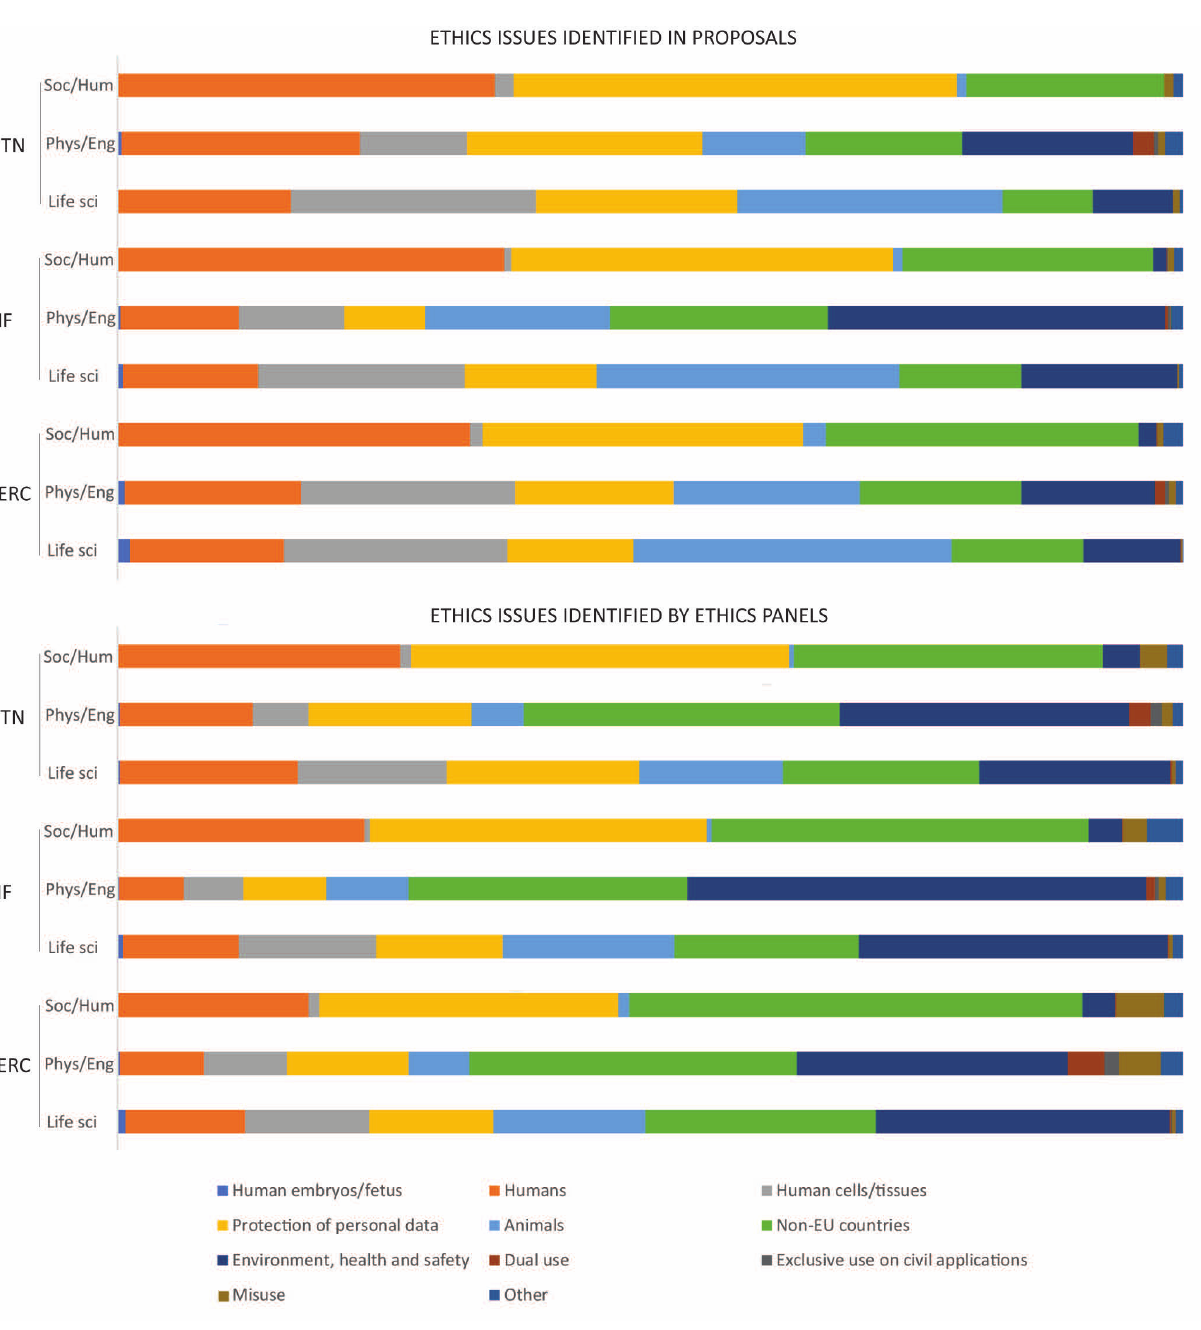
proposals) and Life Science proposals among ITN (12 out of 32 proposals). Half (51.1%) of the proposals that required some kind of ethics monitoring, either by ethics advisors or boards, during the project lifetime also required an ethics